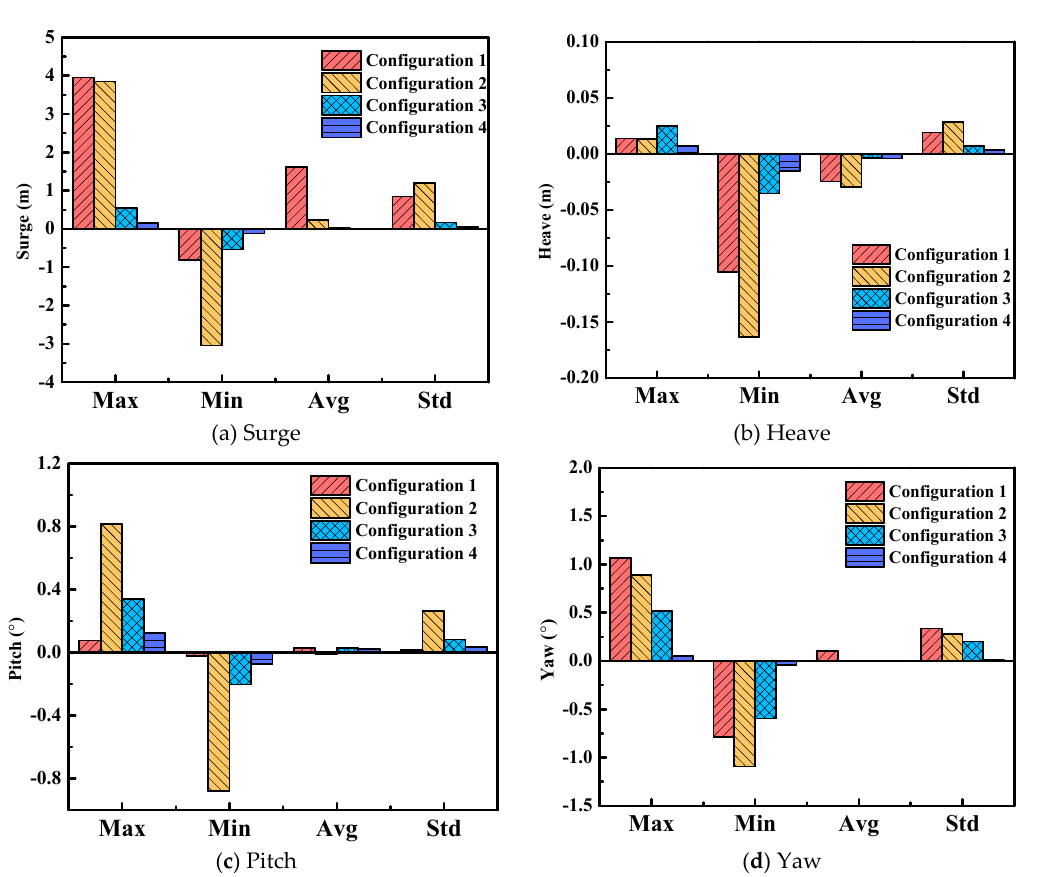
Figure 4. Motion statistics of the platform under different mooring configurations.